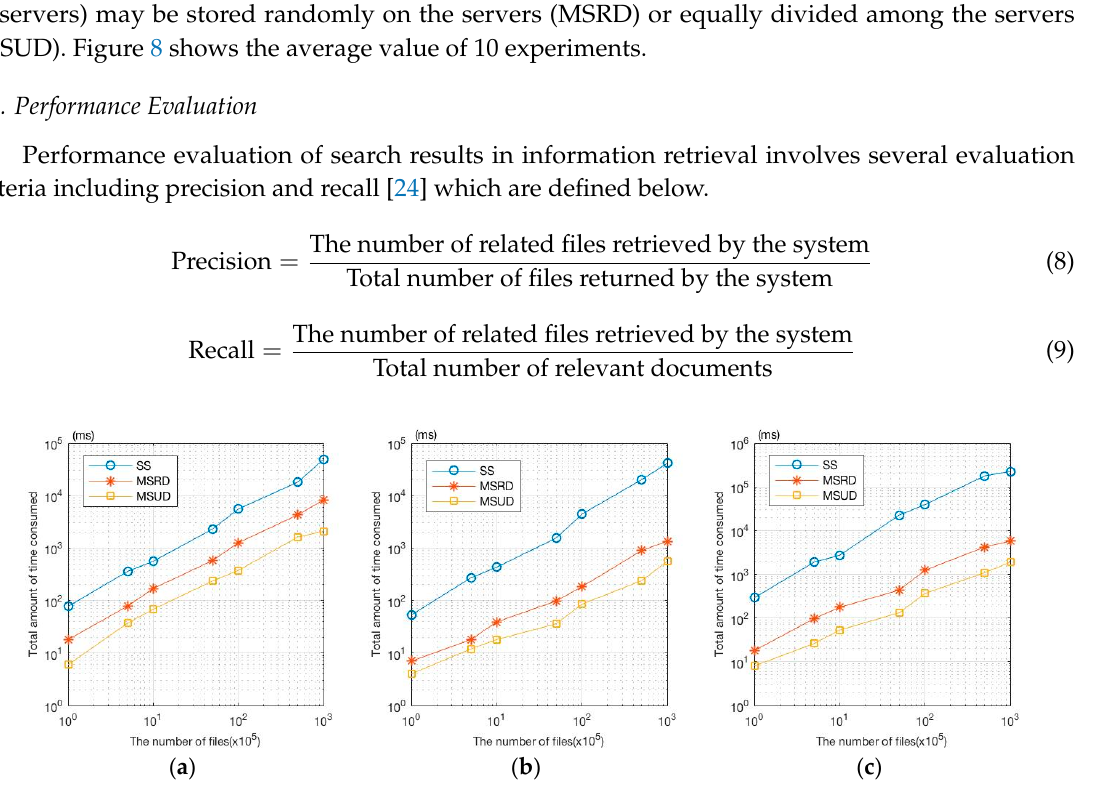
Figure 8. Retrieval efficiency of single server/multiple servers under different segmentation storage mode. ( a ) 10 servers; ( b ) 50 servers; ( c ) 100 servers.